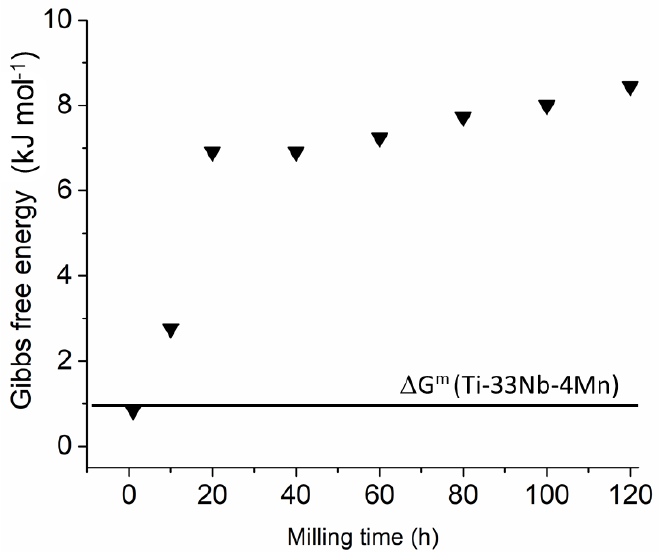
Figure 11. Activity changes as a function of composition for the formation of a solid solution in the Ti-Nb-Mn ternary systems at 298 K.